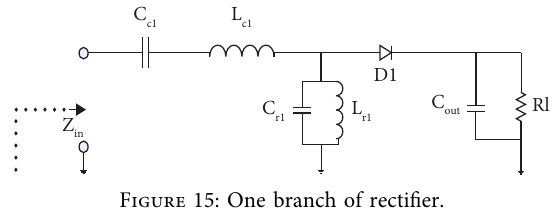
Figure 15: One branch of rectifer.